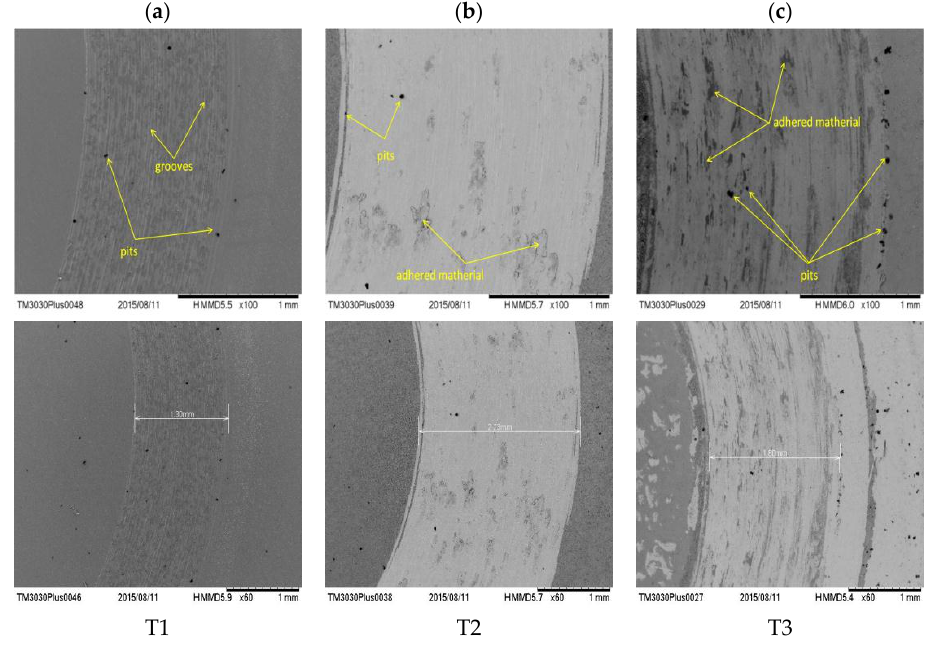
Figure 6. Scanning electron microscopy (SEM) micrographs of the wear tracks for the T1 ( a ), T2 ( b ), and T3 ( c ) alloys after the tribological tests in Hank solution.